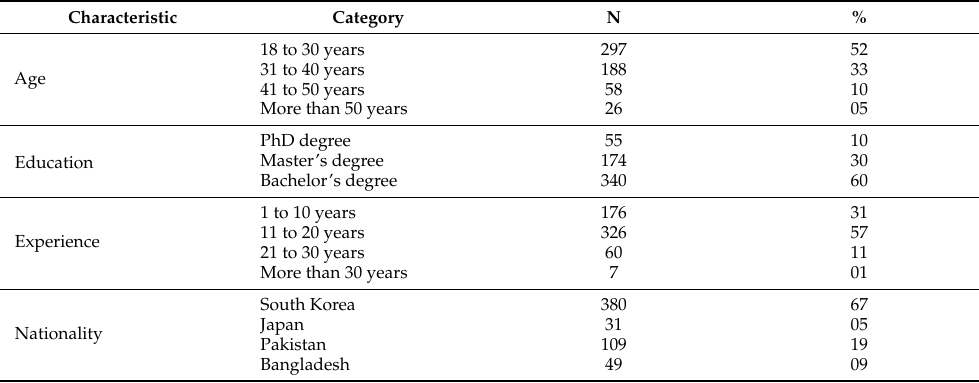
Table 1. Personal characteristics of the survey